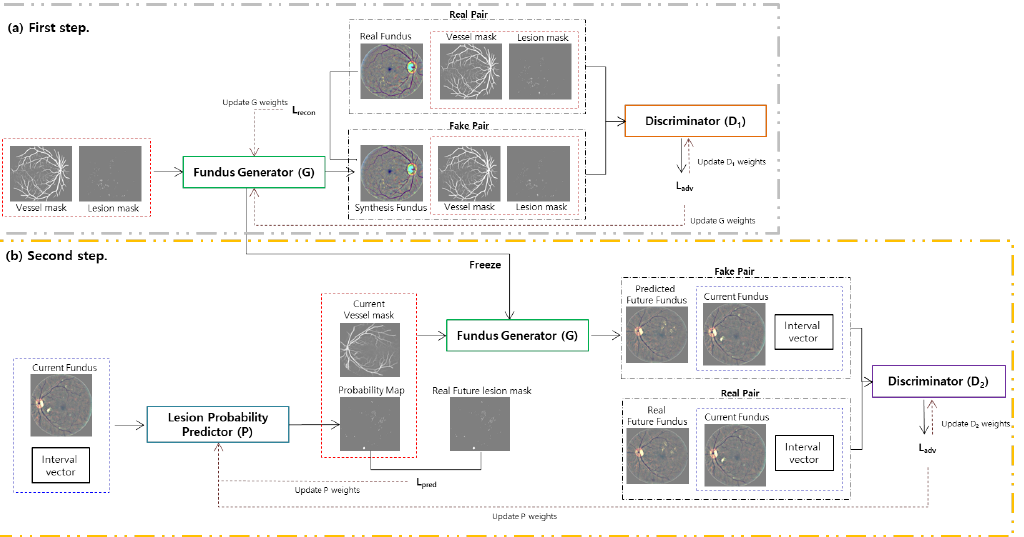
Figure 1. The proposed future-prediction framework by separating the two training steps for efficient learning: Fundus generator training and lesion probability predictor